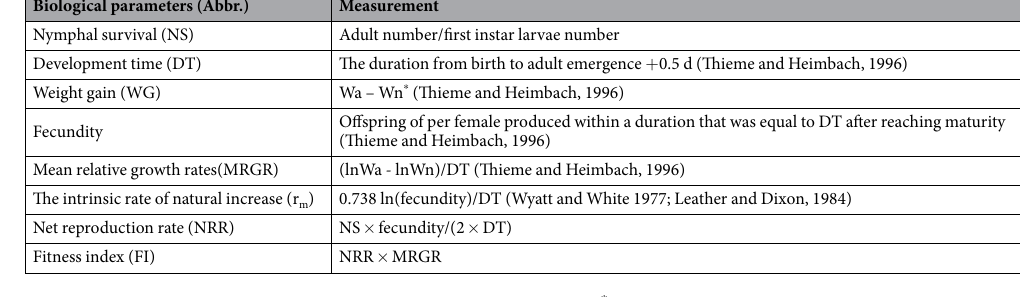
Table 1. The biological parameters were measured in this study. * Wa is the newly adult weight emerged within 24 h, Wn is the first-instar nymph weight (newborn within 24